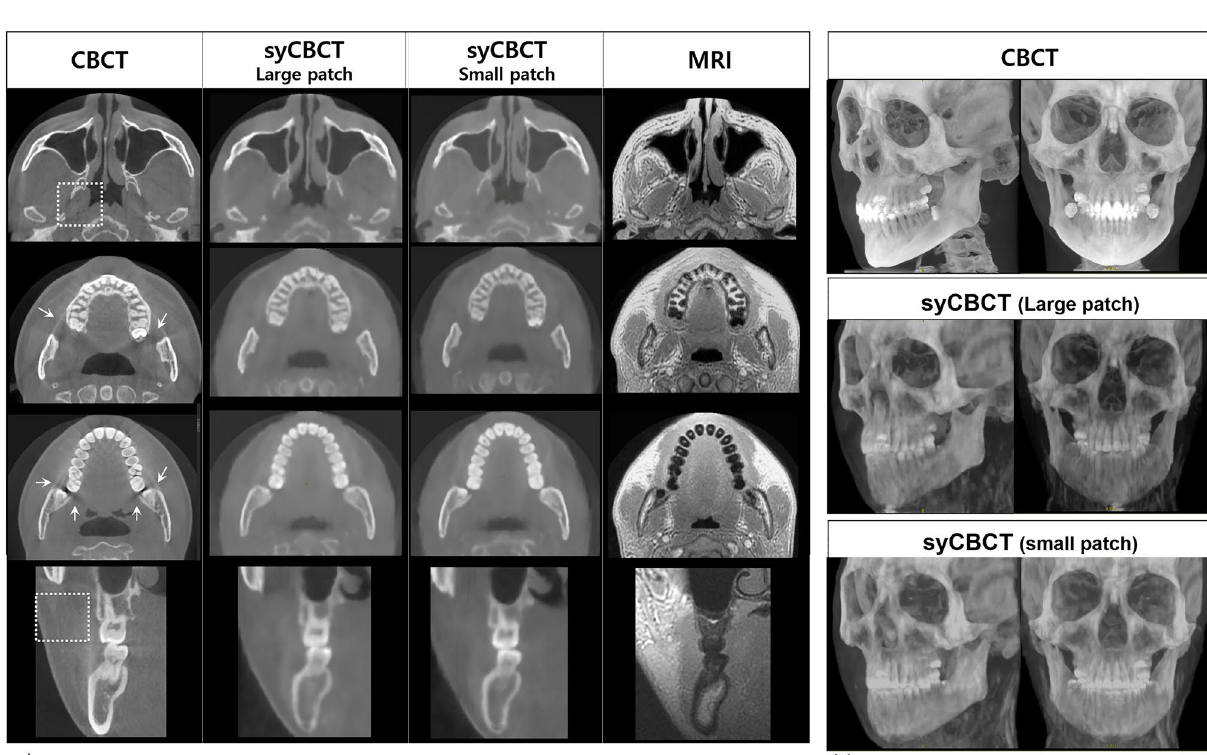
Figure 4. The expert image quality evaluation according to ( a ) artifact, ( b ) noise, ( c ) resolution, and ( d ) overall image grade.